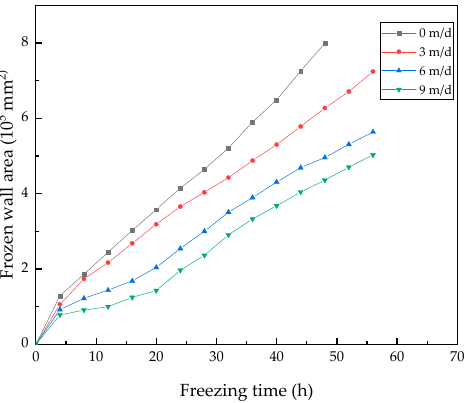
Figure 13. The relationship between the freezing curtain area and the freezing time.